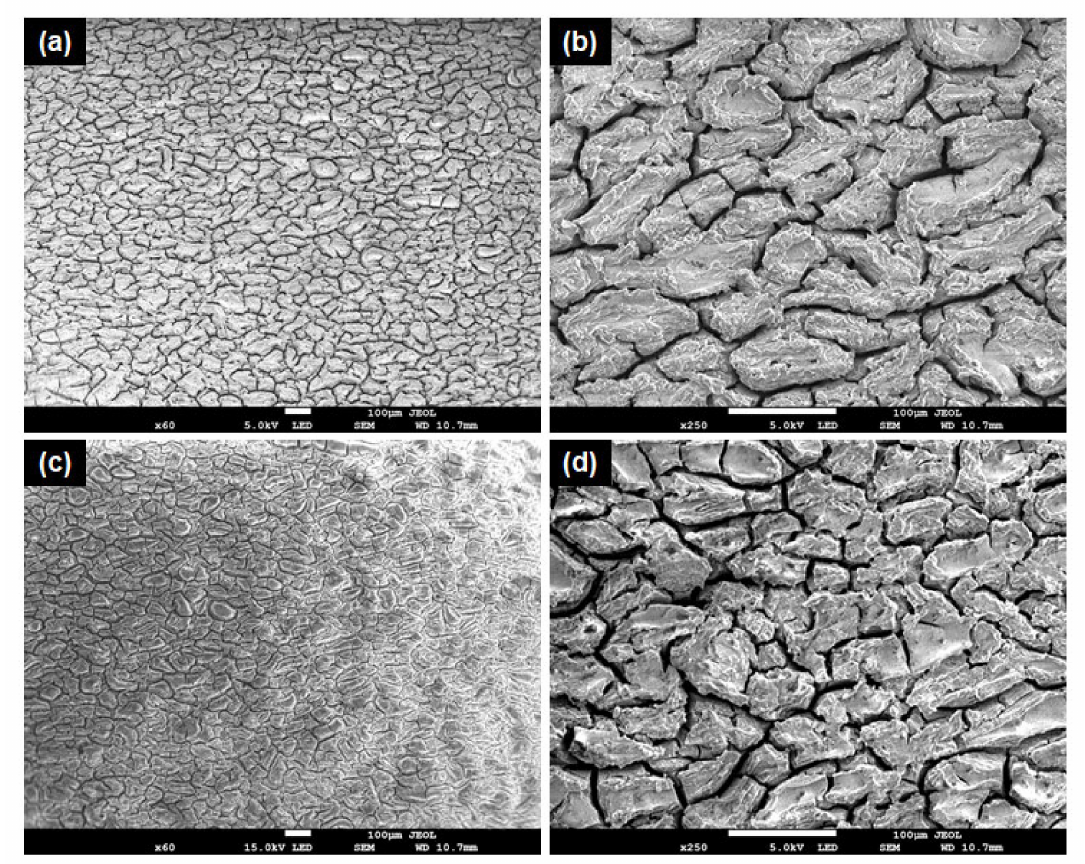
Figure 8. SEM micrograph of the corroded samples ( a , b ) Mg Alloy, ( c , d ) Mg + 3% SiO 2 .